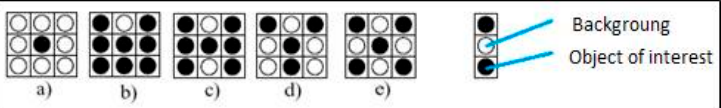
Figure 7. Examples of the number of pixel connections.